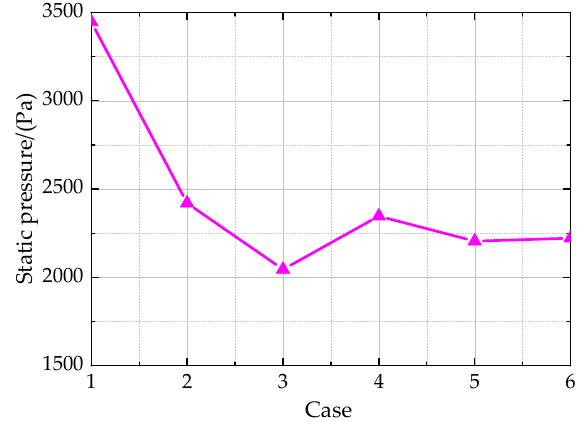
Figure 4. ( a ) Overall calculation CFD model without shroud; ( b ) overall calculation CFD model with shroud; ( c ) cross-section of the shroud; ( d ) PBC calculation CFD model; and ( e ) mesh model with shroud.